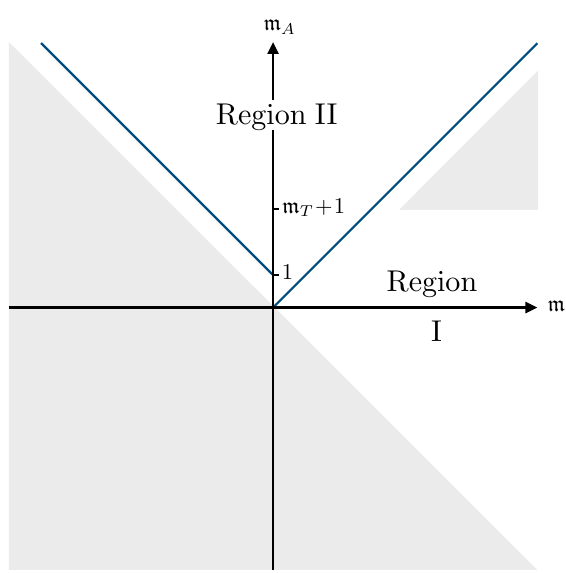
Figure 6 . Summary of the structure of the moduli space and supersymmetric ground states in the ( m ; m A ) plane. There are no supersymmetric ground states in the shaded regions. Region